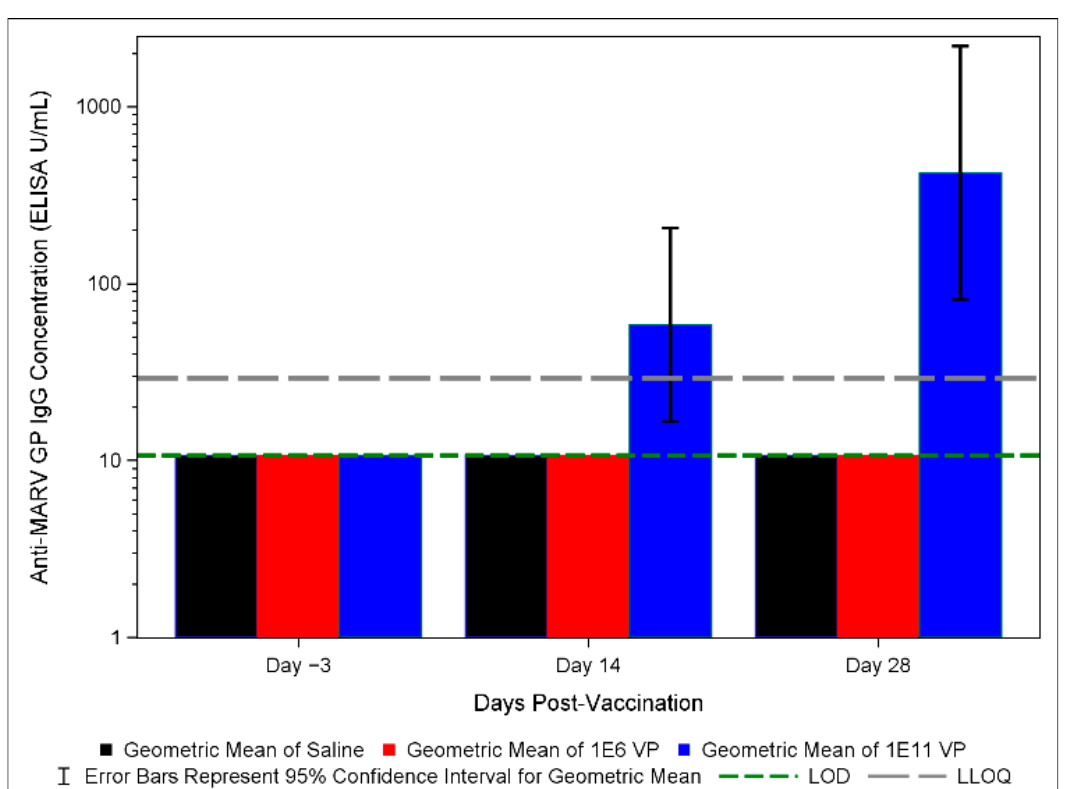
Figure 4. Post-vaccination anti-MARV GP IgG concentrations. Geometric means for each group at day − 3, 14 and 28 post-vaccination are graphed. 1 × 10 11 vp group is shown in blue. 1 × 10 6 vp group is shown in red. Saline control group is shown in black. LOD is shown as a green dashed line, and the LLOQ is shown as a gray dashed line. Error bars represent 95% confidence internal for the geometric mean.